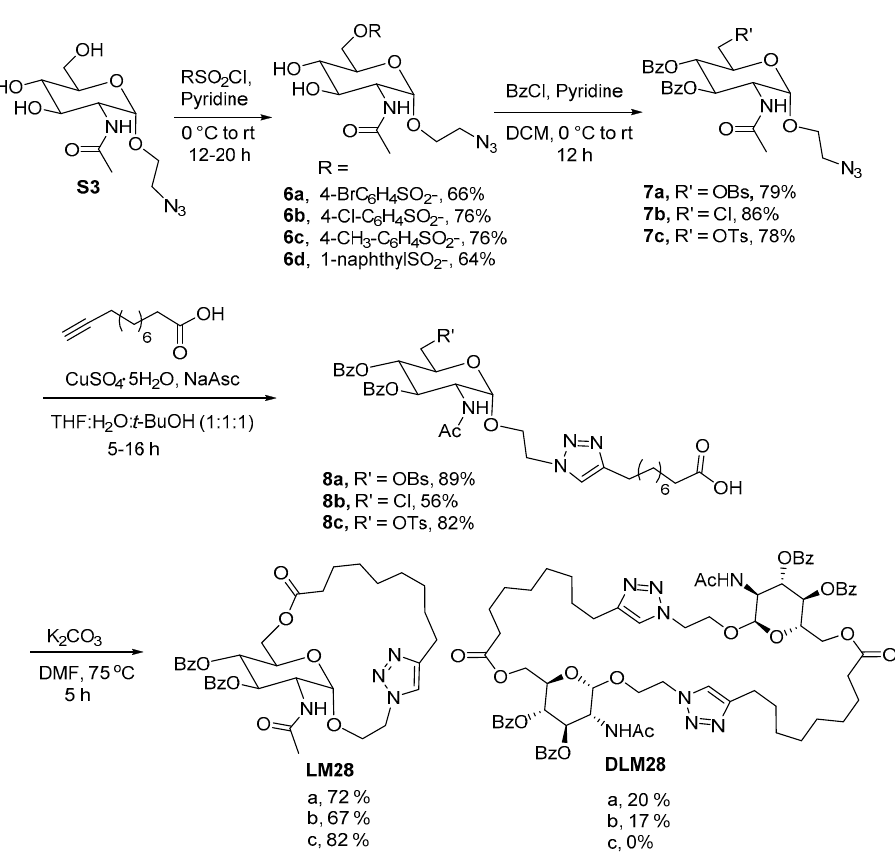
Scheme 1. Macrolactonization using different sulfonates as the leaving